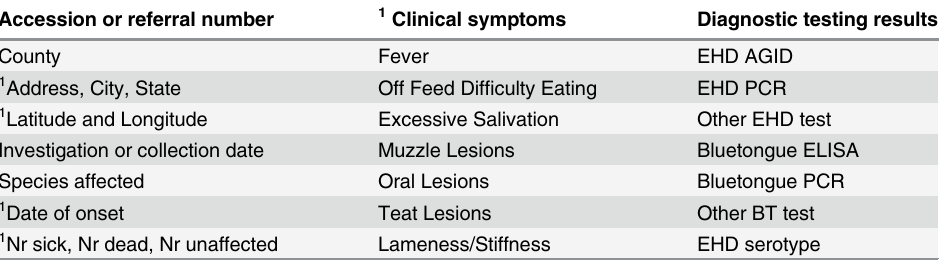
Table 1. Data requested from USDA – APHIS Veterinary Services Area Offices on foreign animal dis- ease investigations and state diagnostic lab submissions between June 1 and December 31,